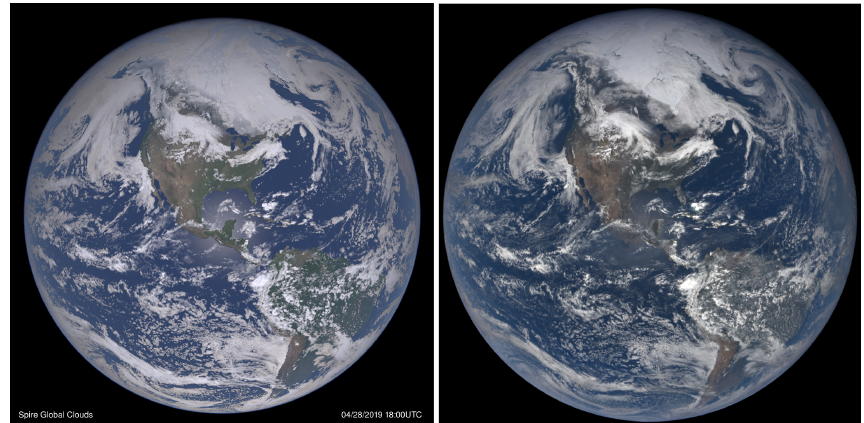
Figure 12. Side-by-side comparison of global cloud coverage viewed from space at approximately 18:00UTC on 28 April 2019 as provided by DSCOVR EPIC (camera-observed image, right), analyzed by LAPS (21km horizontal resolution), and visualized by SWIm (simulated image,